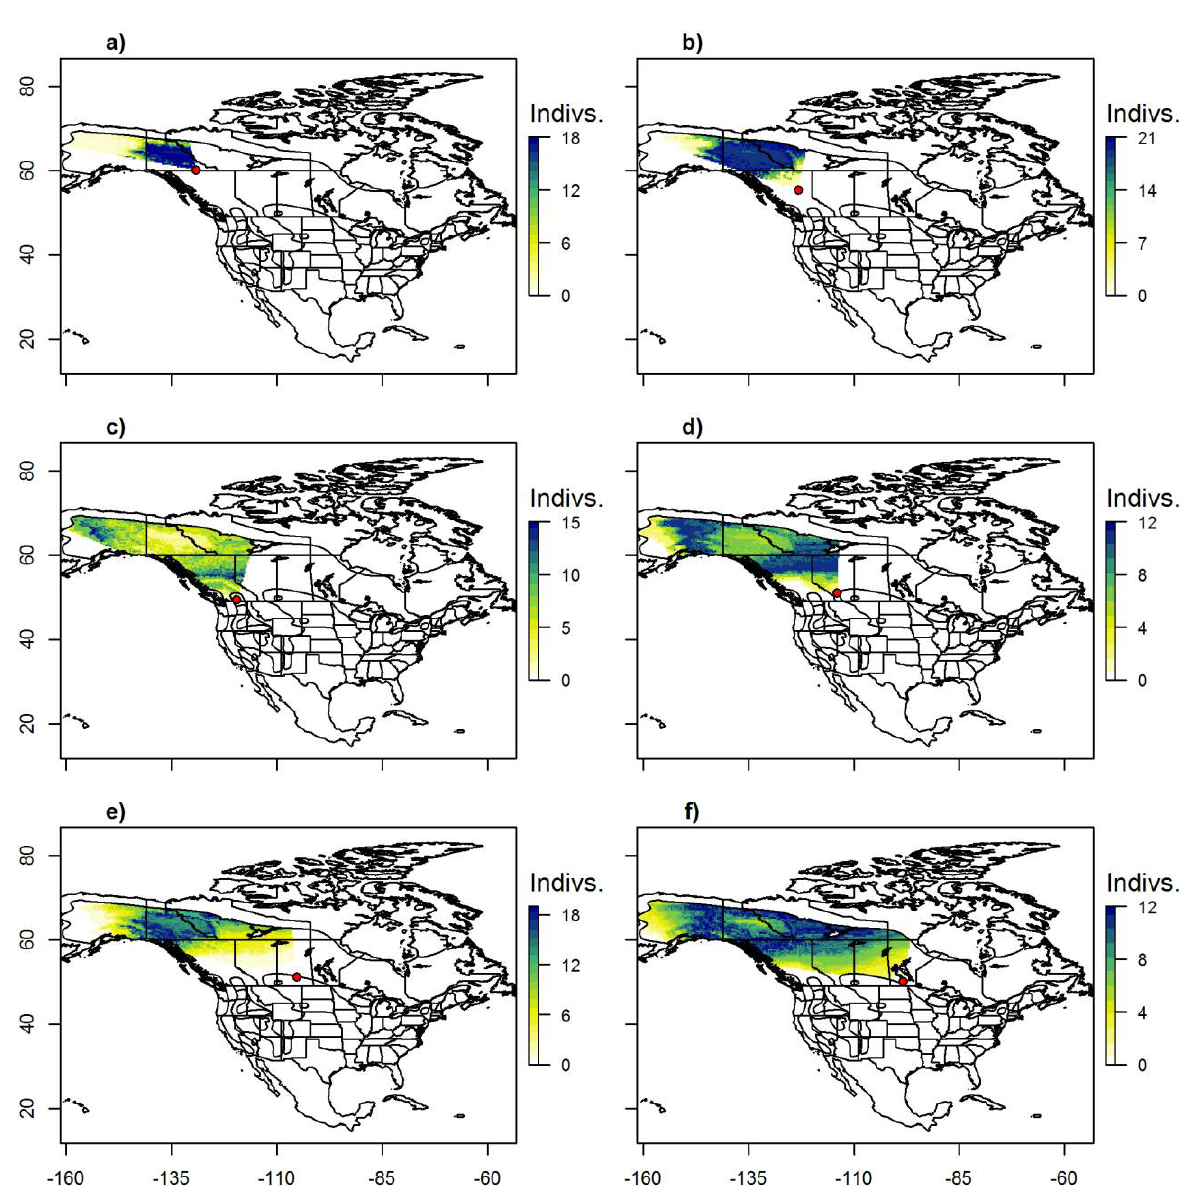
Figure A2.7: Probable origins of Ruby-crowned Kinglets ( Regulus calendula ) captured during fall migration at CMMN stations in a) the Yukon (ACBO (n=19)); b) Northern British Columbia (MNO (n=21)); c) Southern British Columbia (VLBO (n=32)); d) Southern Alberta (IBS (n=18)); e) Saskatchewan (LMBO (n=20)); f) Manitoba (DMBO (n=20)); g) Western Ontario (TCBO (n=20)); h) Southeast Ontario & Southwest Québec (MBO (n=9), PEPTBO (n=11)); and i) Eastern Canada (ABO